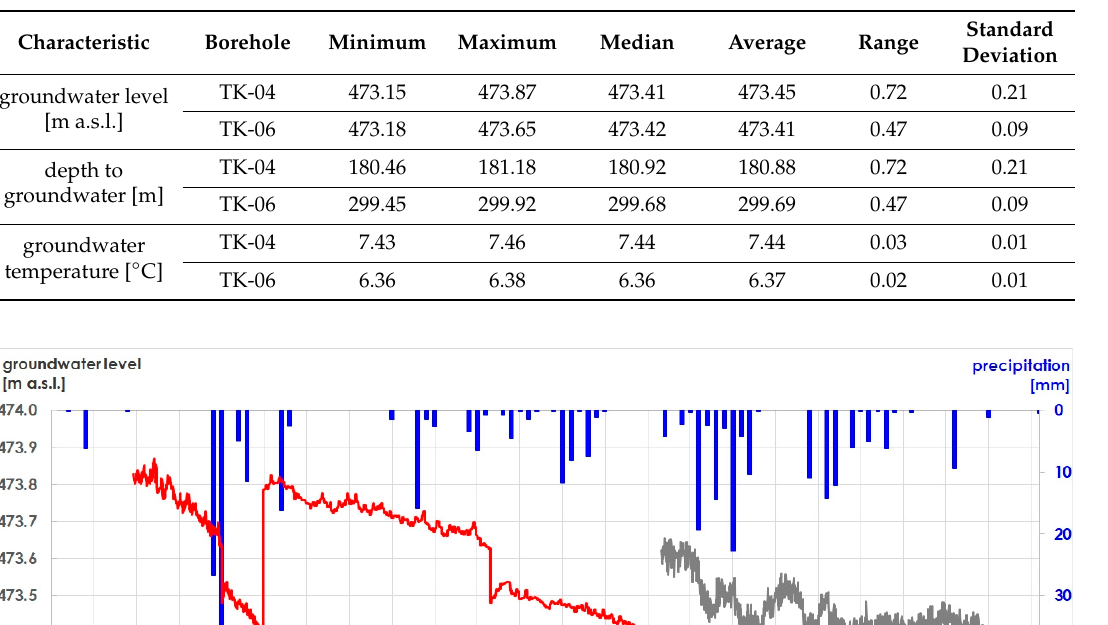
Table 5. Brief descriptive statistics of groundwater level and temperature measurements in the TK-04 and TK-06 boreholes.